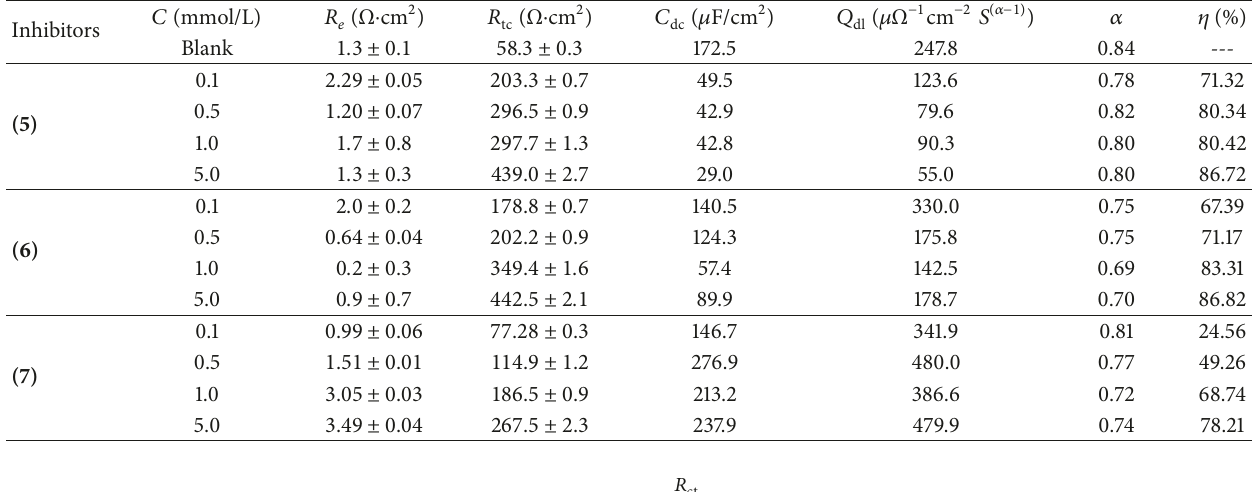
Table 3: Kinetic parameters derived from Nyquist plots of steel immersed in 1 M HCl with different concentrations of Camphor thiosemicarbazone (5) , Carvone thiosemicarbazone (6) , and Pulegone thiosemicarbazone (7) at 293 K. Inhibitors